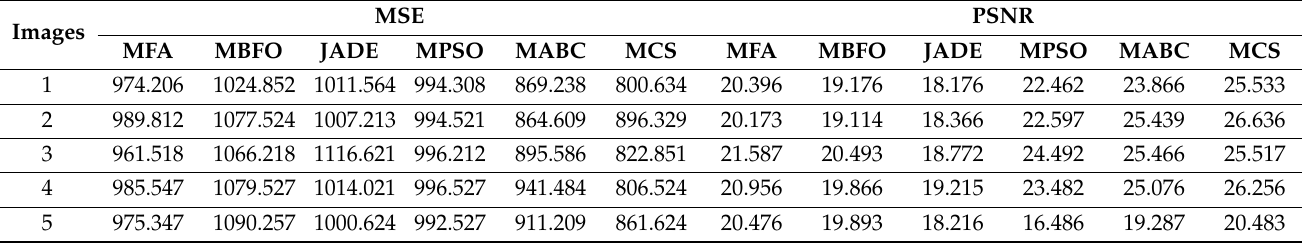
Table 8. MSE and PSNR using different optimization algorithms with the GLCM method.